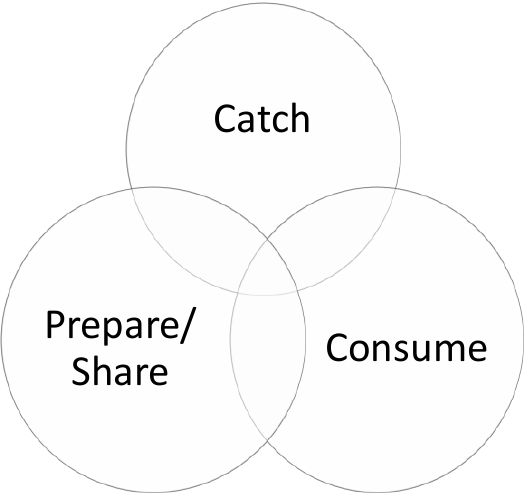
Figure 1. Three main sub-groupings of hunting/fishing/gathering activities associated with Indigenous participation in land-based practices with implications for human health.